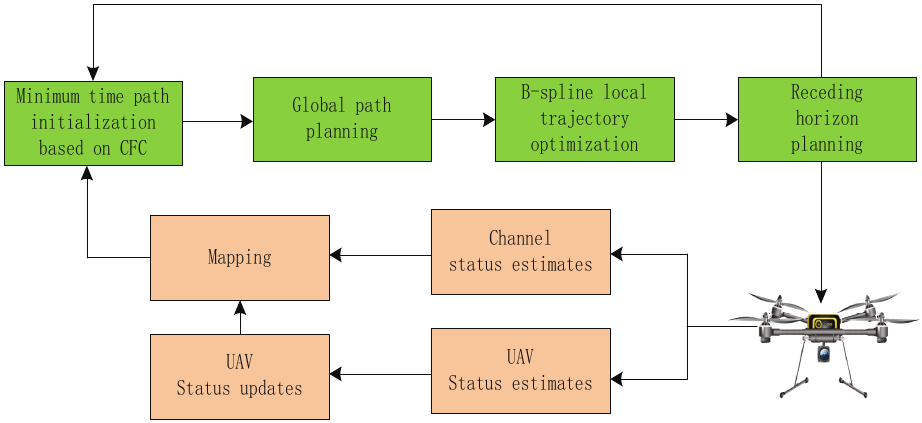
Figure 2. Block diagram of presented autonomous